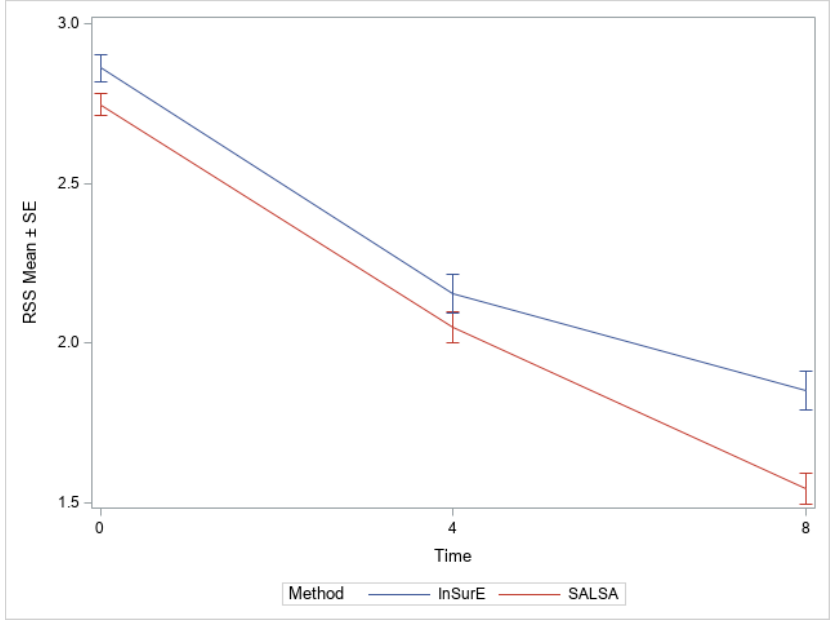
Figure 3. Respiratory Severity Score at time of surfactant administration and at intervals up to 8 h post-surfactant.